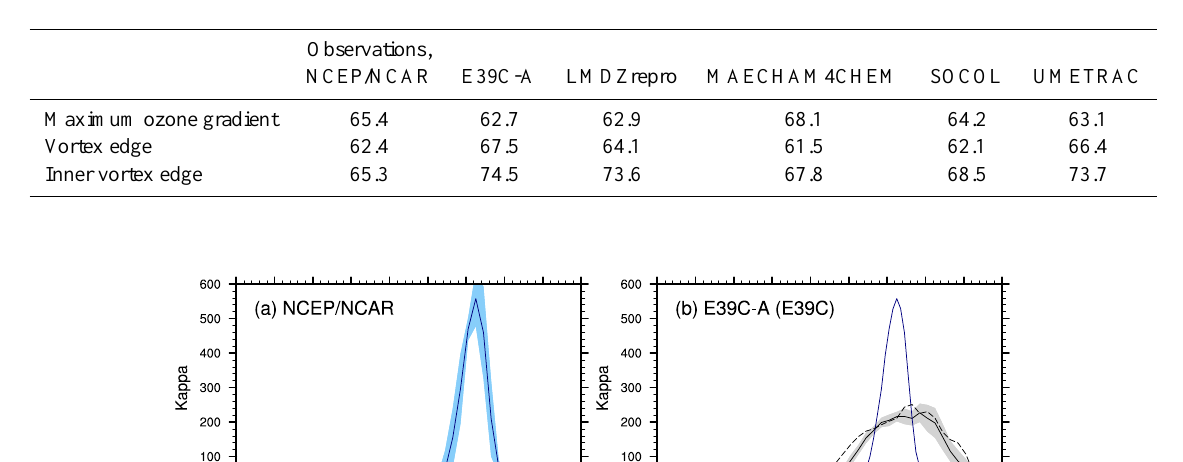
Table 2. 1995–1999 average equivalent latitude of the maximum in the meridional total column ozone gradient, the vortex edge and the inner vortex edge from observations, NCEP/NCAR reanalysis and the five CCMs (see Fig. 5).